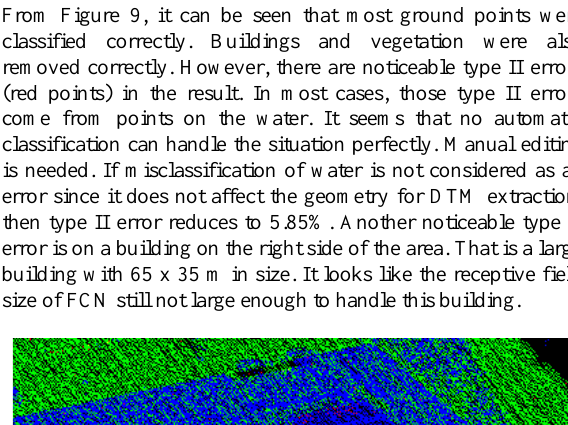
Figure 9. Labeled point clouds on AHN testing sample. (Green: correctly labeled ground, Blue: correctly labeled non- ground, Yellow: ground misclassified as non-ground, and Red: non-ground misclassified as ground)